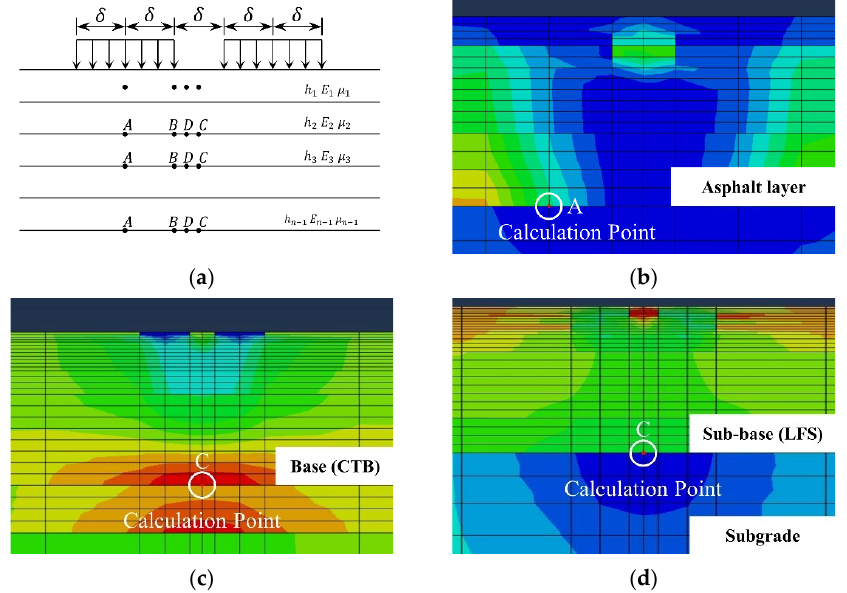
Figure 4. Calculation basis: ( a ) elastic layer system; ( b ) calculation point of tensile strain; ( c ) calculation point of tensile stress; ( d ) calculation point of vertical compressive strain.